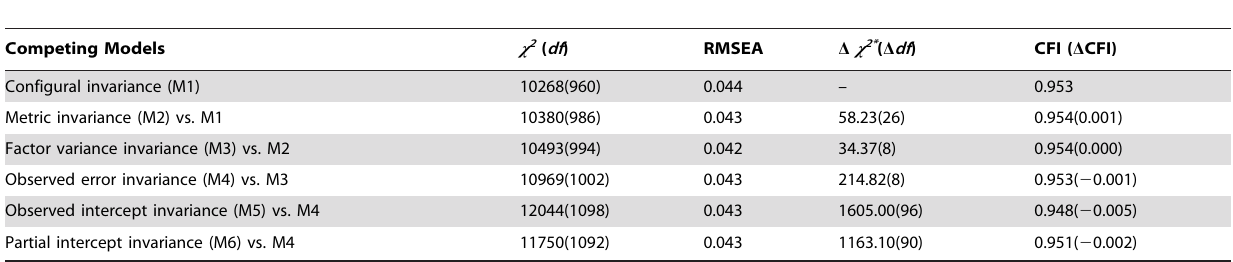
Table 4. Longitudinal measurement invariance tests of demand-control-support factor model over time [ N =4913].